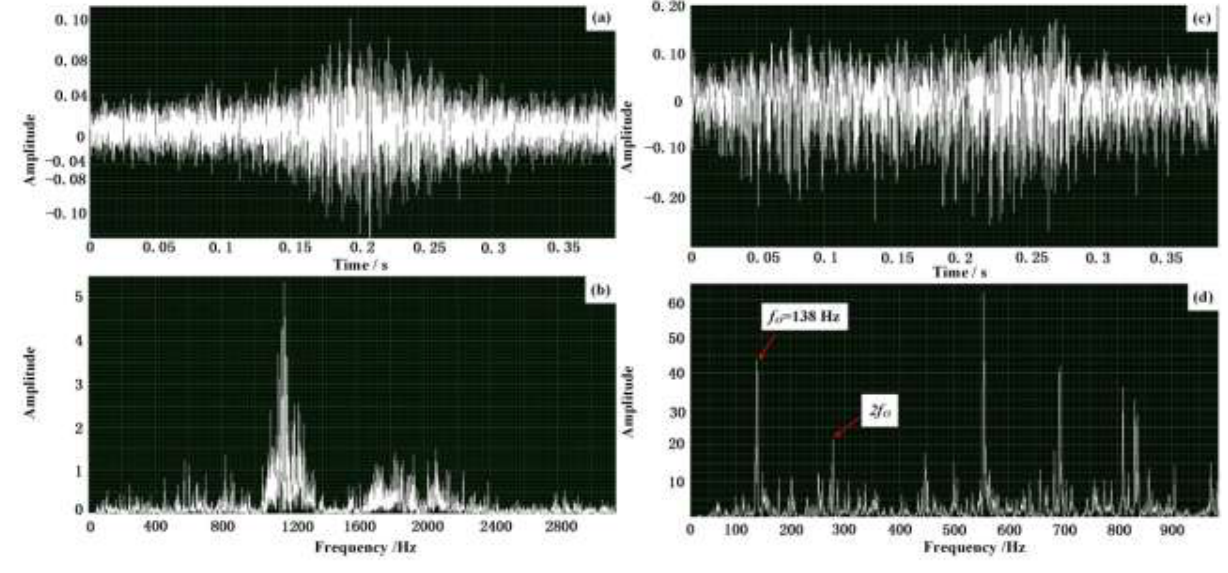
Figure 14. Effectiveness verification via the designed embedded system: ( a , b ) the waveform and the spectrum of the input Doppler distorted signal of the defective train bearing with a defect on the outer-race; ( c , d ) the waveform and the spectrum of the output restored envelope signal via the designed embedded